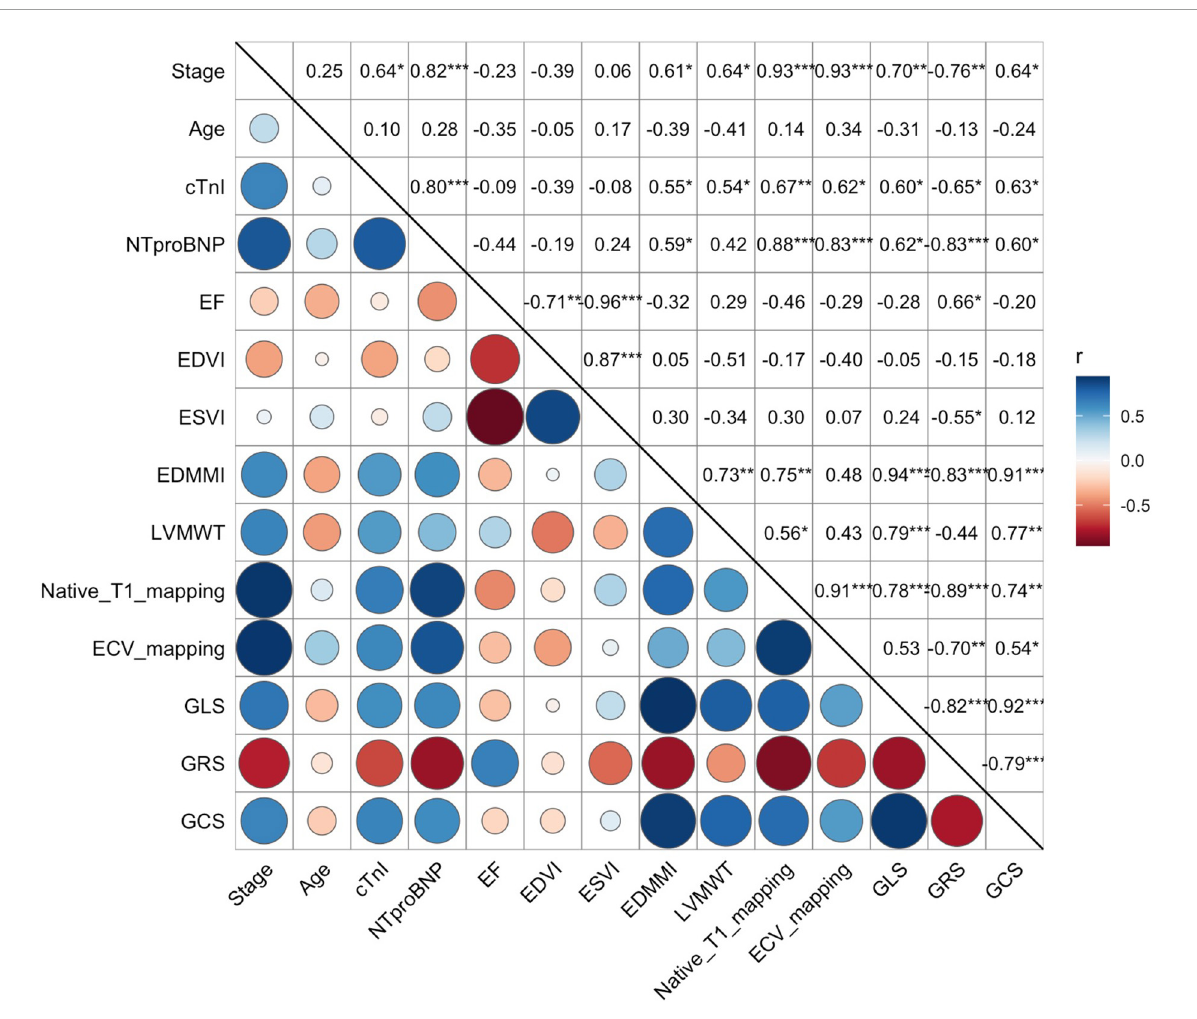
FIGURE5 Correlation between the Mayo stage, biochemical markers (cTnI and NT-proBNP), and all CMR-related parameters, including EF, EDVI, ESVI, EDMMI, LVMWT, Native Tl mapping, ECV mapping, GLS, GRS, and GCS). Both native Tl mapping, ECV mapping, GLS, GRS, and GCS were strongly correlated to the Mayo stages ( r = 0.93, 0.93, 0.70, 0.76, 0.64, respectively). However, EF, EDVI, and ESVI showed no significant correlation. Correlation between continuous variables was assessed using Pearson’s r correlation, such as native Tl, ECV mapping and strain values, etc., and with categorical variables using Spearman P correlation, such as Mayo stage. cTnI, Cardiac Troponin I; NT-proBNP, N-terminal pro-B-type natriuretic peptide; EF, left ventricle ejection fraction; EDVI, left ventricle end-diastolic volume index; ESVI, left ventricle end-systolic volume index; EDMMI, left ventricle end-diastolic maximum mass index; LVMWT, left ventricle maximum wall thickness; ECV, extracellular volume; GCS, global circumferential strain; GLS, global longitudinal strain; GRS, global radial strain. Symbols: P , Spearman correlation coefficient; r , Pearson correlation coefficient; blue, positive correlation; red, negative correlation; circle size, the degree of the